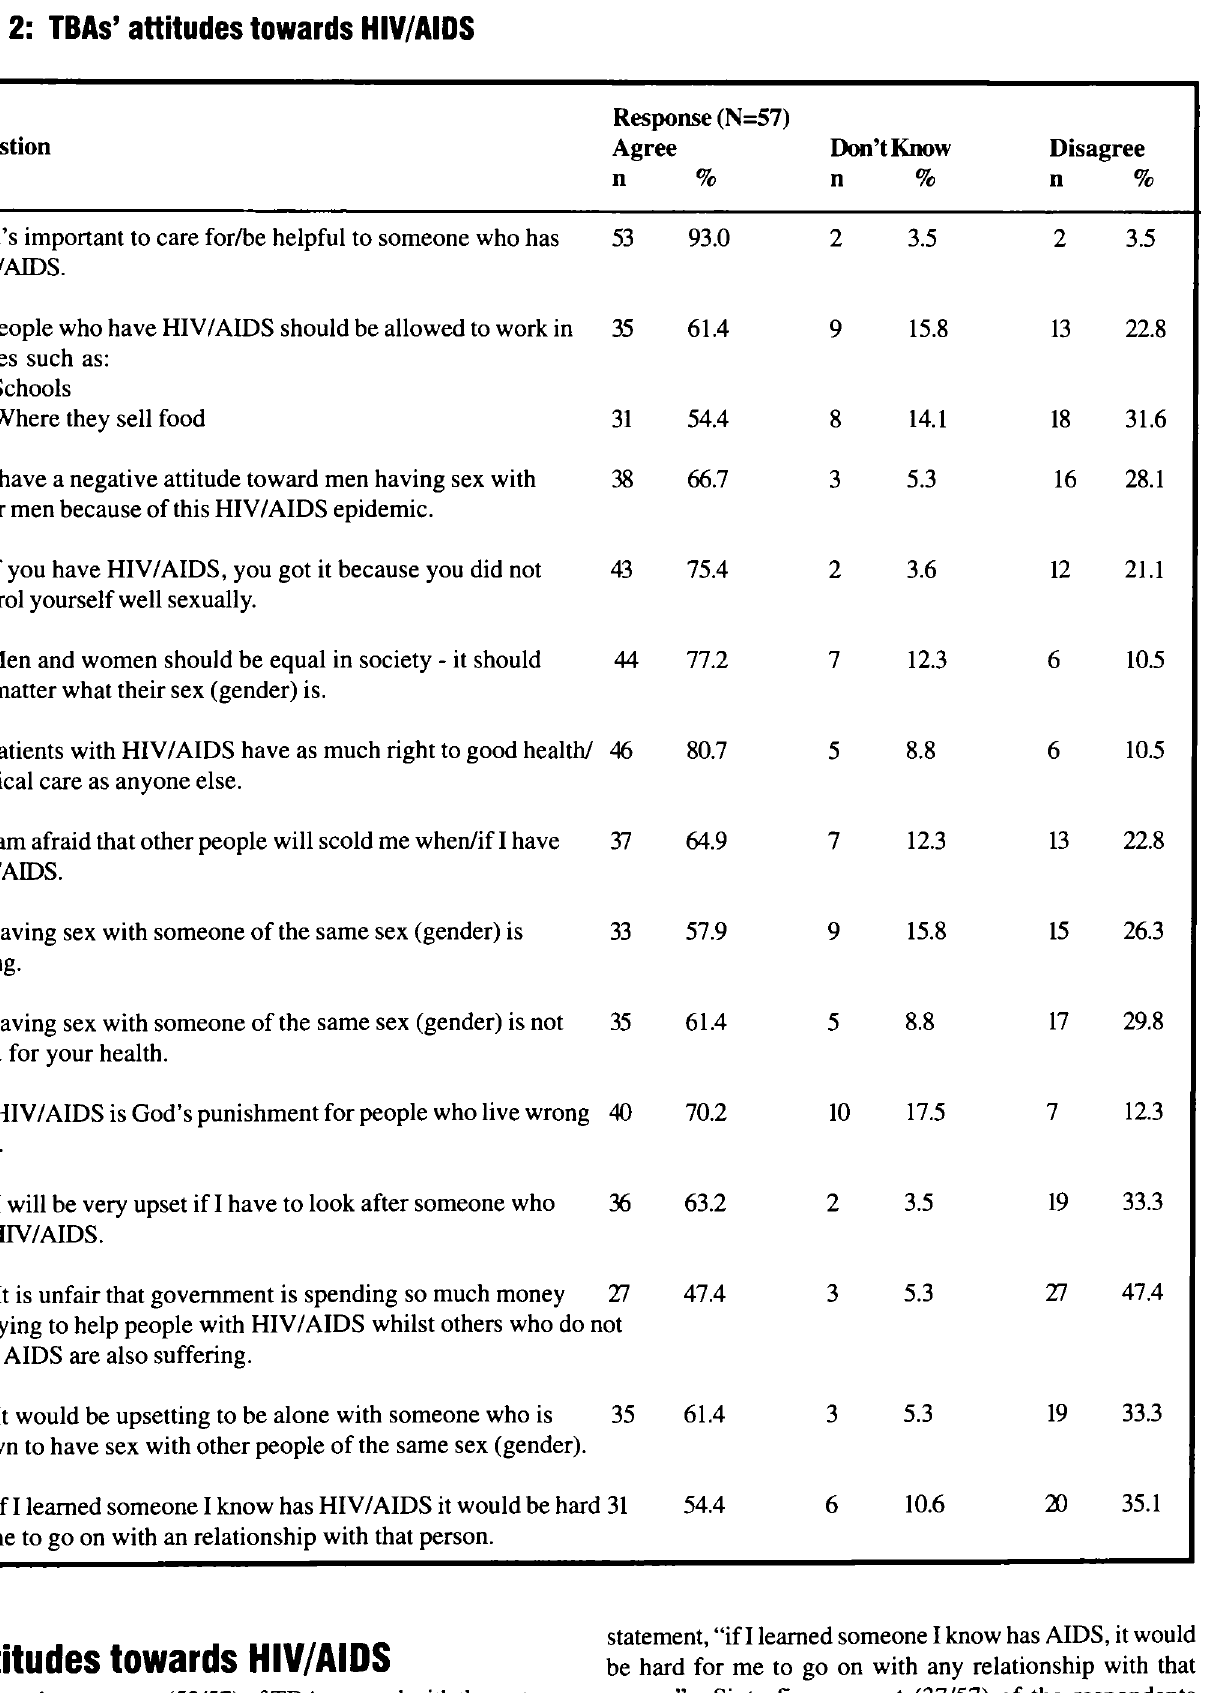
Table 2: TBAs’ attitudes towards HIV/AIDS